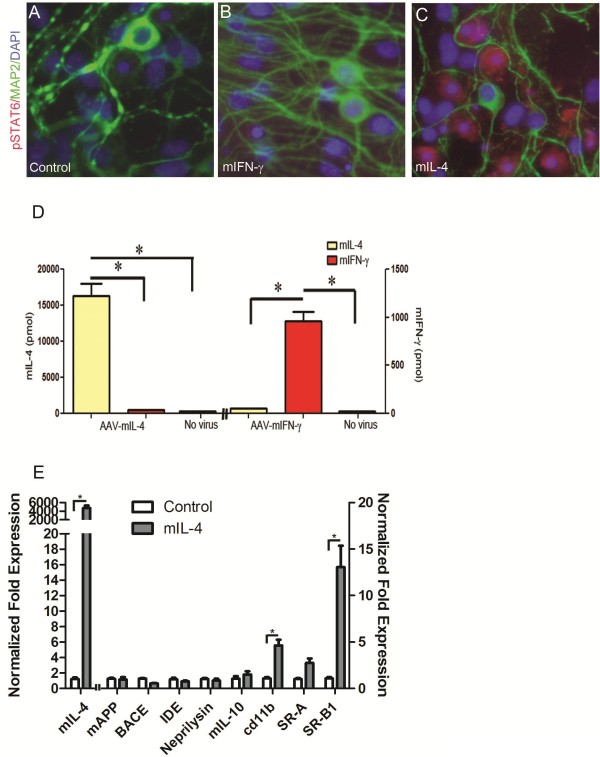
Characterization of rAAV2/1-mIL-4 treated primary wild type mouse neuroglial culture. A-D. rAAV2/1-mIL-4 or rAAV2/1-mIFN-γ (2x108 viral genomes) was used to transduce primary mouse neuroglial cultures for 60 hrs in chamber slides. Upregulation of phosphorylated STAT6 (568 nm; red fluorescence) could be seen in mIL-4 expressing cultures (C) but not in mIFN-γ expressing cultures (B) or untreated culture containing no viruses (A). MAP2 (488 nm; green) and DAPI (350 nm, blue) were used to depict neuronal processes and nucleus respectively. mIL-4 and mIFN-γ expression in these cultures was verified by ELISA from media collected from respective cultures (D). Magnification, 400x. (*p < 0.05, t test). E. Expression of mouse endogenous APP, BACE1, IDE and neprilysin levels are unchanged in rAAV2/1-mIL-4 expressing primary mixed neuroglial cultures compared to untreated control cultures using real time Q-PCR. mIL-4 expression augments scavenger receptors and cd11b levels. Data, expressed as relative levels of mRNA expression, represents averaged fold change values obtained from mIL-4 expressing mice, relative to averaged values obtained from EGFP expressing mice. Data for mIL-4 RNA is plotted on the left x-axis while the rest of the data are plotted on the right x-axis. Data is representative of two independent experiments (t test, *p < 0.05). Data represents mean ± sem.